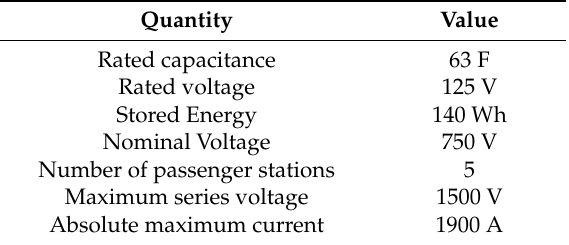
Table 4. Results of the optimization procedure.